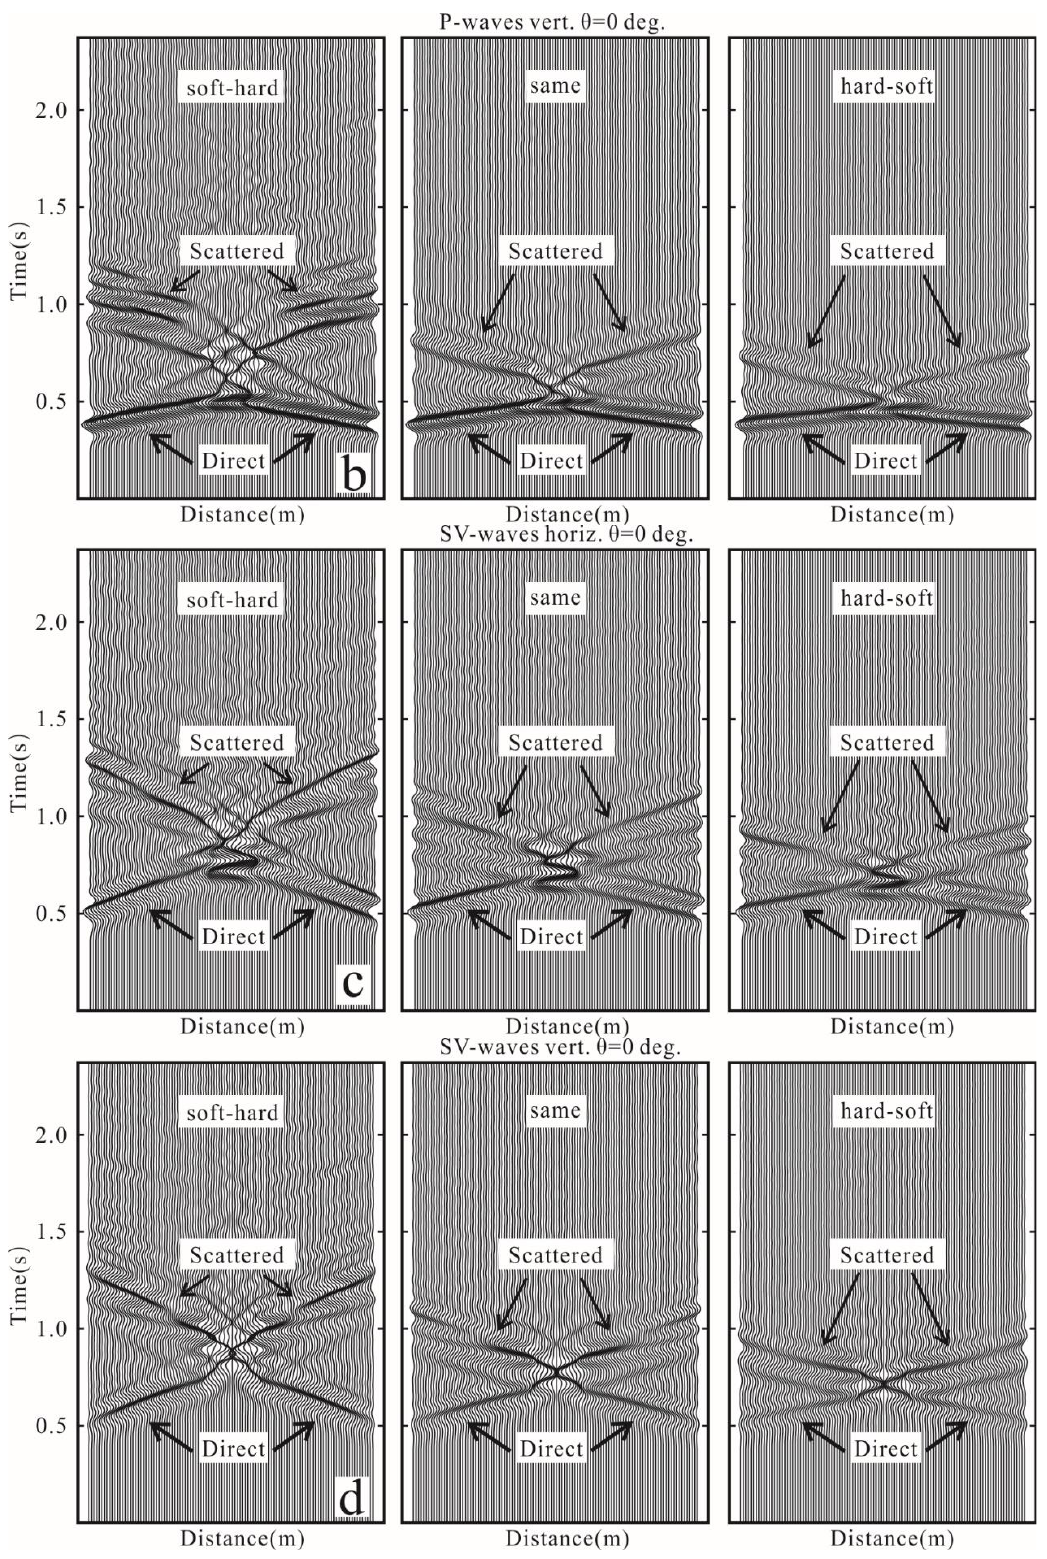
Figure 16. Synthetic accelerogram (accelerations recorded along the ground with time) generated along the topographic profile, plotted from the horizontal or vertical components of P waves and SV waves arriving from the left of the model at an incident angle of 0, ( a ) horizontal P waves with vertical direction, ( b ) vertical P waves with vertical direction, ( c ) horizontal SV waves with vertical direction ( d ) vertical SV waves with vertical direction